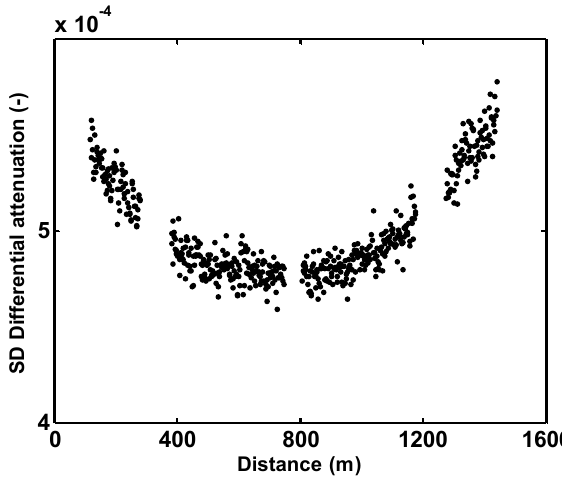
Figure 3. Standard deviation over time of differential attenuation calculated at each sampling interval along the cable as measured over the complete measurement period. Blank stretches coincide with sharp transitions and splices where the standard deviation was much larger than the values shown